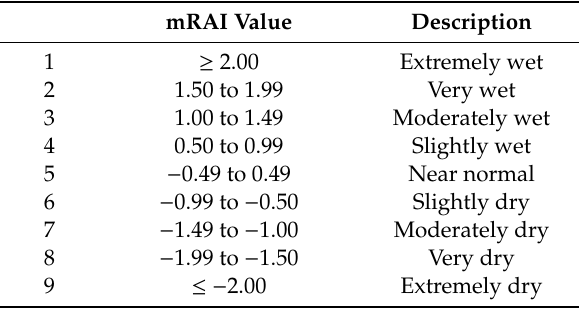
Table A1. Classification of the Modified Rainfall Anomaly Index (mRAI). mRAI